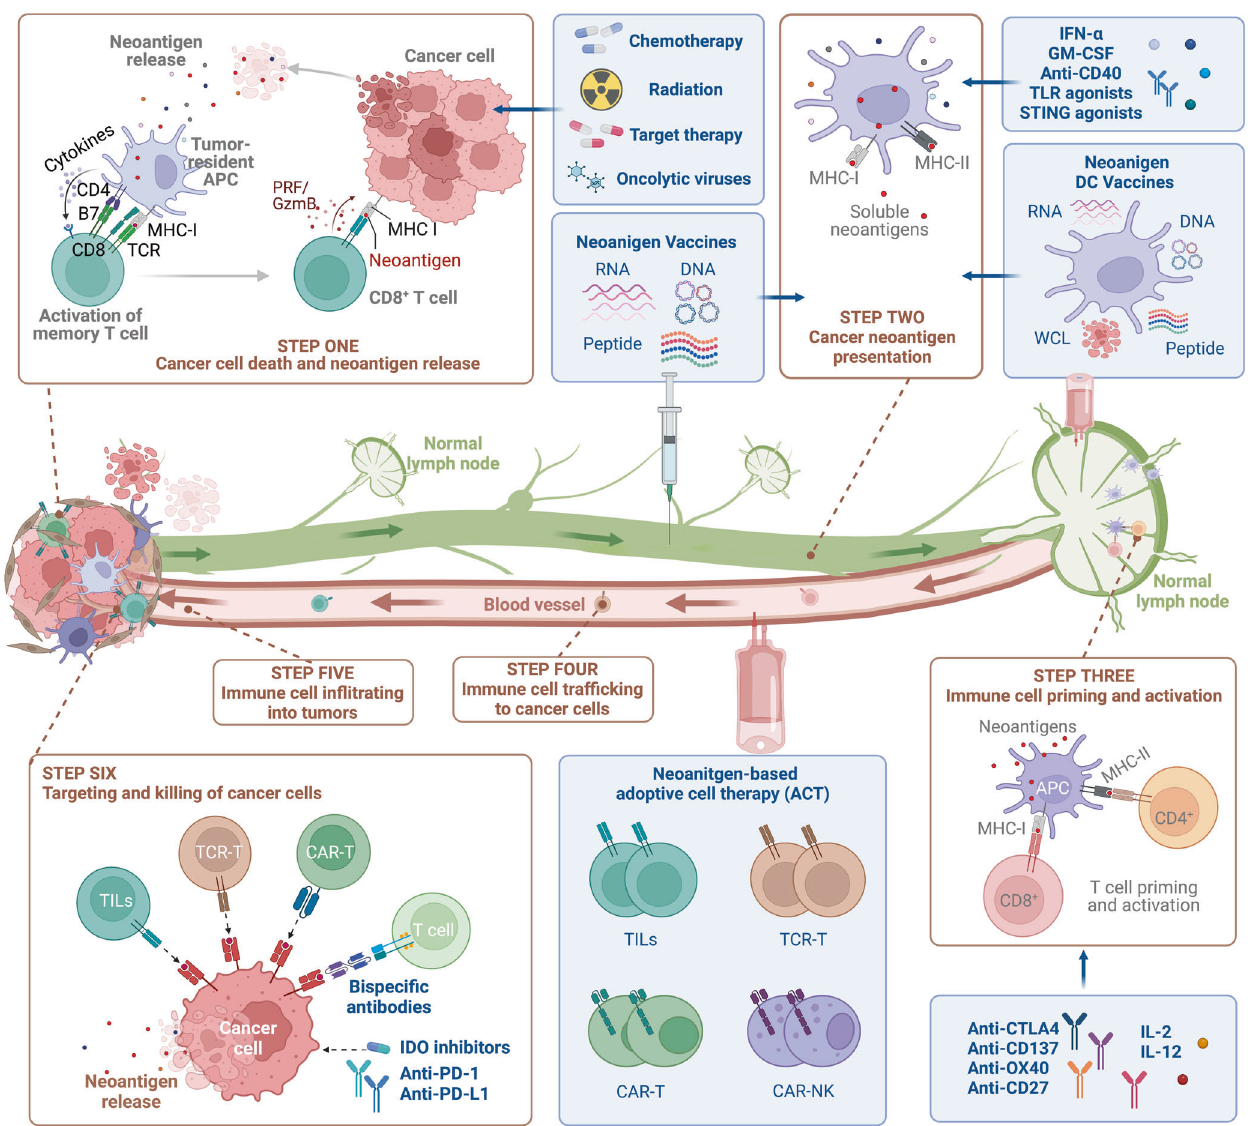
Fig. 6 Combinational neoantigens-based anti-tumor strategies. The “ Cancer-Immunity Cycle ” refers to the sequential events that must be initiated, proceeded, and expanded to achieve an anti-cancer immune response, resulting in the ef fi cient eradication of cancer cells. Brie fl y, neoantigens generated by oncogenesis are released and captured by DCs (step 1). DCs convey the collected neoantigens on MHC-I and MHC- II molecules to T cells (step 2), resulting in priming and activation of effector T cell responses against cancer-speci fi c neoantigens (step 3). Subsequently, activated effector T cells migrate to (step 4) and in fi ltrate into (step 5) the tumor bed, where they recognize and fi nally destroy their target cancer cells (step 6). The death of cancer cells produces additional tumor-associated neoantigens (step 1 once more), which broadens and intensi fi es the immune response in subsequent cycles. Therefore, cancer immunotherapies have been designed to reinitiate or amplify a self-sustaining cycle of cancer immunity. Multiple immunotherapies have been developed to target the rate-limiting steps in “ Cancer-Immunity Cycle ” , including enhancing the neoantigen release by chemotherapy, radiation therapy and oncolytic virus, increasing the quantity and quality of tumor-reactive T cells through cancer vaccine and ACTs, and boosting the in fi ltration and cytotoxicity ef fi cacy of immune cells via checkpoints